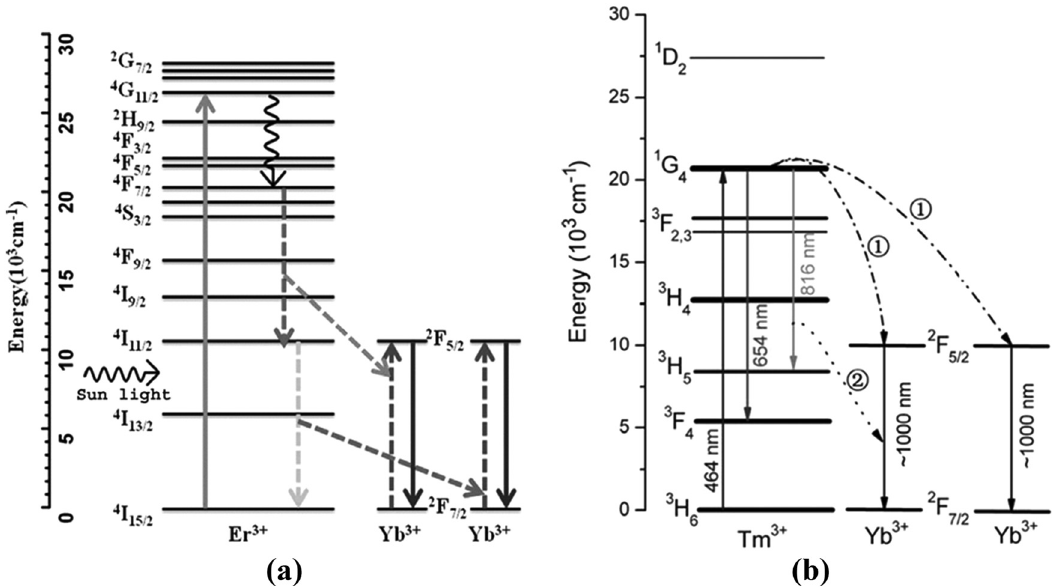
Figure 3: Energy - level diagram explaining the mechanisms of down - conversion in groups of ions ( a ) Er 3 + and Yb 3 + [ 30 ] and ( b ) Tm 3 + and Yb 3 + [ 53 ]